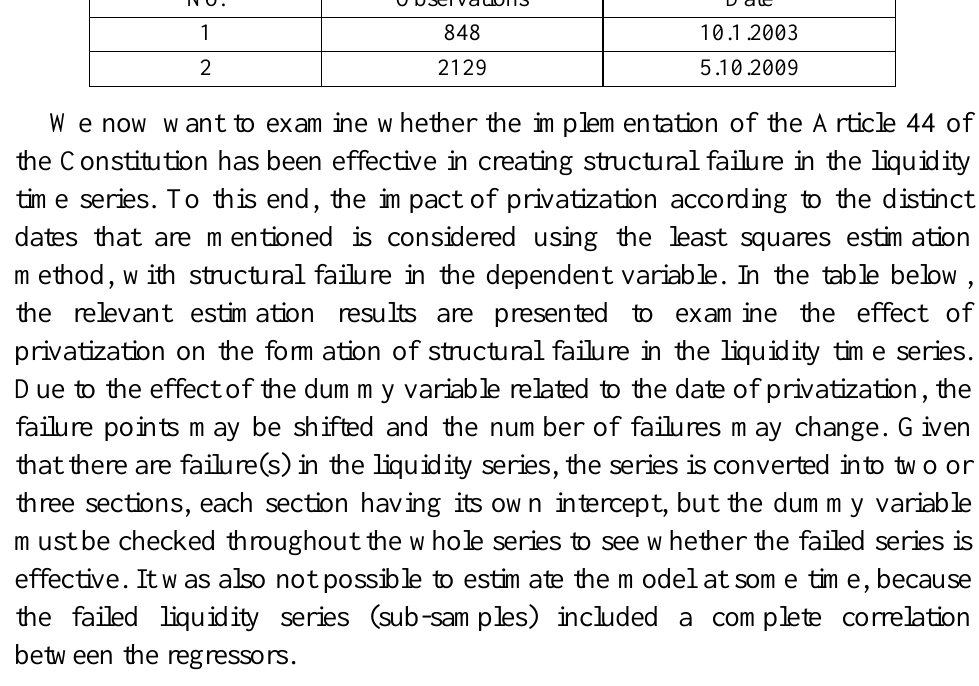
Table 15: Estimates of the effect of the privatization in Iran's economy on structural